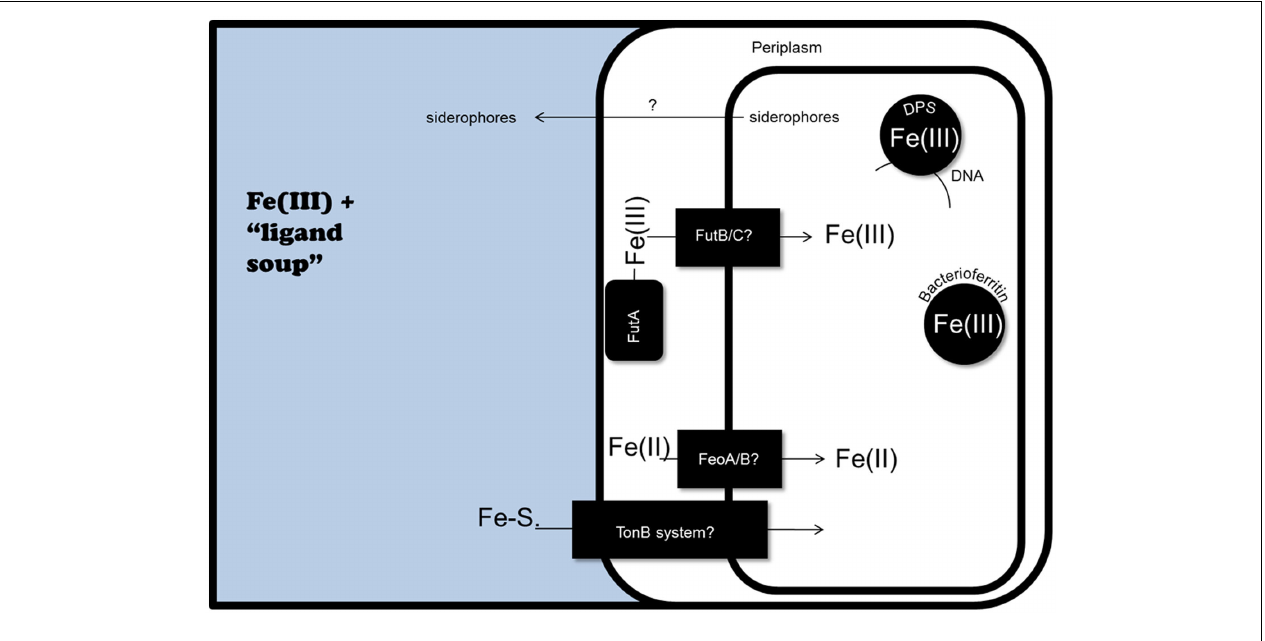
marine cyanobacteria genomes suggests Fe(II) uptake could also occur. Finally, the Synechococcus sp. PCC 7002 genome contains genes for siderophore biosynthesis, as well as Fe-siderophore (Fe-S.) uptake via a TonB dependent receptor system.Within the cell, iron could be sequestered by bacterioferritin and